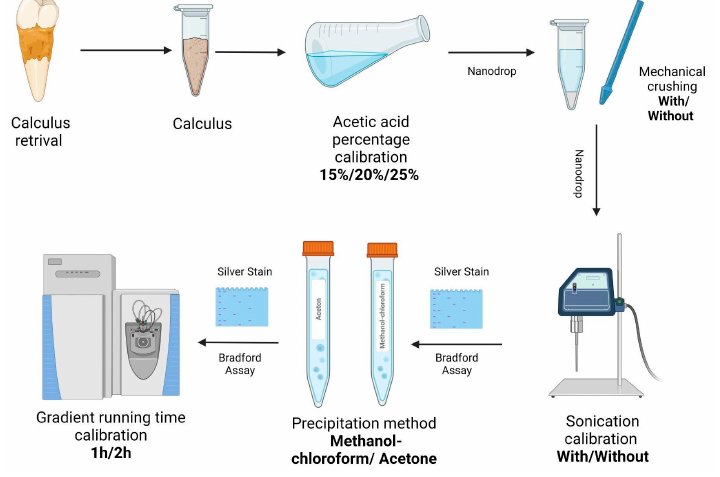
Figure 7. Protocol schematic overview.